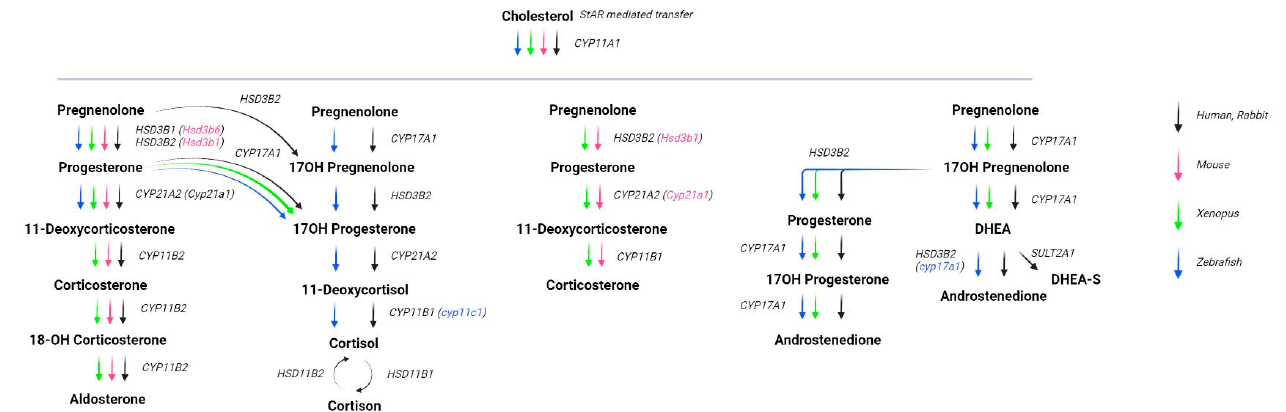
Figure 1. The known adrenal gland steroids synthesis pathways for the discussed models. Steroid precursors and products are denoted in bold. The genes and which protein products are responsible for the corresponding synthesis step, are denoted in italics. The names of the genes are mentioned in human mode, but if there is orthologous gene with different name, it is denoted in parentheses by color of the corresponding species. Created with BioRender.com.